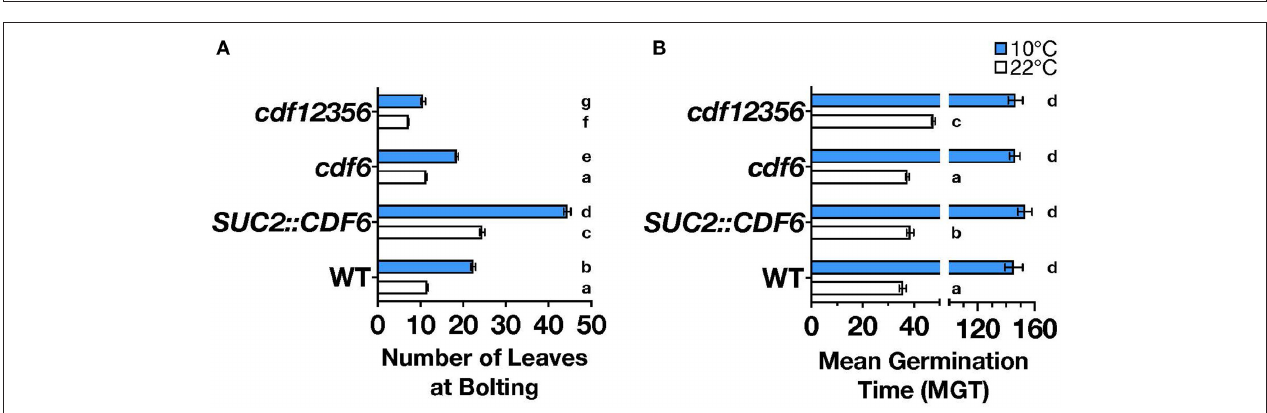
FIGURE 1 | Vasculature-specific CDF6 expression is gated by the clock in response to cold stress. (A) GUS activity in WT and two independent T3 CDF6::CDF6-GUS plants (Lines A and B) indicate the expression pattern of CDF6 at ZT0 in 11-day-old seedlings grown in long-day (16-h light: 8-h dark) conditions. Bars correspond to 500 µ m. (B) qRT-PCR of CDF6 transcript abundance in WT (Col-0) and SUC2::CCA1 in ambient temperature. qRT-PCR of CDF6 transcript abundance in (C) continuous 22 ◦ C or 1h of 10 ◦ C exposure in (D) WT, (E) 35S::CCA1 , and (F) SUC2::CCA1. Seedlings were grown in continuous light (LL) for 2 days after 8 days of entrainment in diurnal (12-h light:12-h dark; LD) cycles. Gray and white bars indicate the subjective night and day periods, respectively. Time (ZT) represents hours. mRNA levels are normalized to IPP2 (mean values ± standard error (SE), n = 3; *** P ≤ 0.001, ** P ≤ 0.05, * P ≤ 0.01; unpaired student’s t -test).